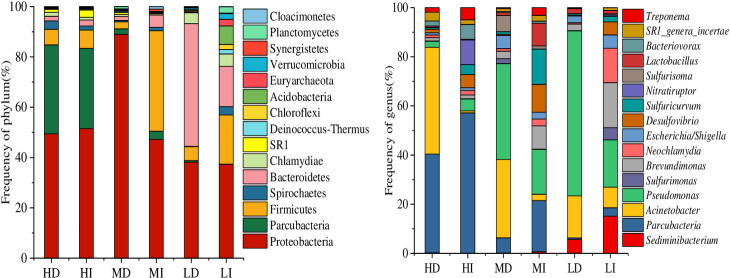
The abundance of bacterial phylum and genus accounts for the top 10% in each treatment.